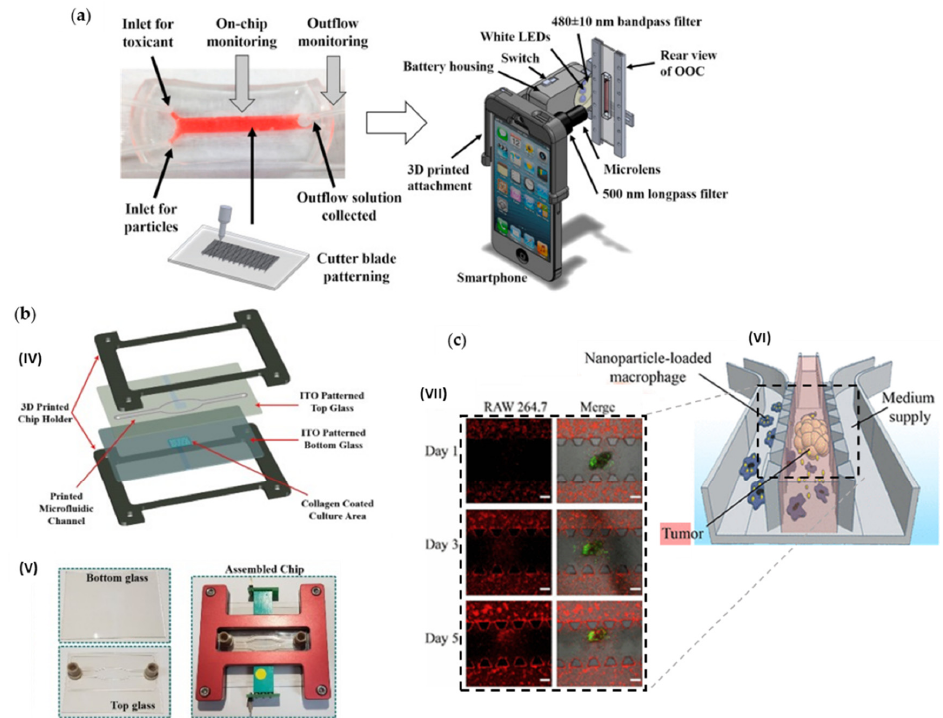
Figure 7. ( a ) Non-destructive, in situ monitoring of drug-induced nephrotoxicity on kidney-on-a- chip developed by Cho et al. [57] that quantifies immunocapture and immunoagglutination using a Smartphone-based fluorescence microscope. Adapted with permission from [57]. ( b ) Lung cancer- on-chip platform fabrication developed by Khalid et al. [59]: (IV) Expanded schematic view of the assembly of the 3D printed parts and (V) microfluidic chip images of the separate parts and final assembled chip. Adapted with permission from [59]. ( c ) Tumor-microenvironment-on-a-chip devel- oped by Wang et al. [60] for drug-carrying macrophages and their delivery to tumors in vivo and in vitro: (VI) Schematic illustration, and (VII) Confocal images showing migration of RAW 264.7 cells (red) toward SKOV3 spheroids (green) in microfluidic channels on days 1, 3, and 5. Scale bars rep- resent 200 μ m. Adapted with permission from [60].